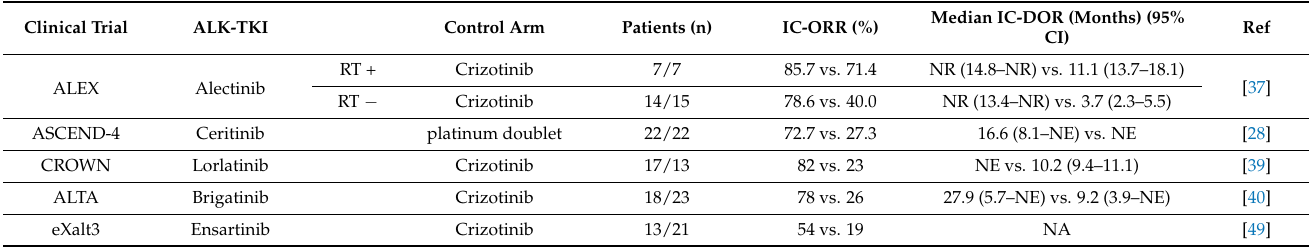
Table 3. Efficacy for measurable brain metastases in first-line